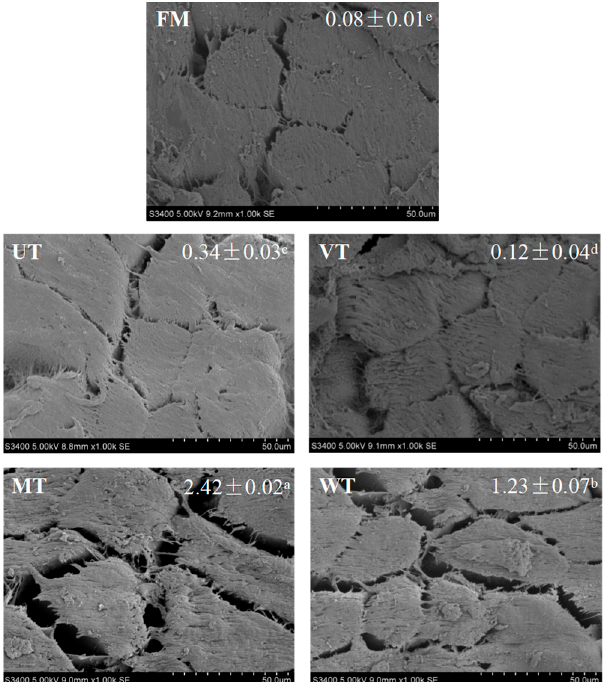
Figure 3. Change in microstructure of porcine longissimus dorsi induced by thawing methods. FM, fresh meat; UT, ultrasonic thawing (20 °C); VT, vacuum thawing (25 °C); MT, microwave thawing; WT, water immersion thawing (14 °C). The gap areas (mm 2 ) are given as the means ± SD, with different lowercase letters (a–e) indicating significant differences ( p < 0.05).